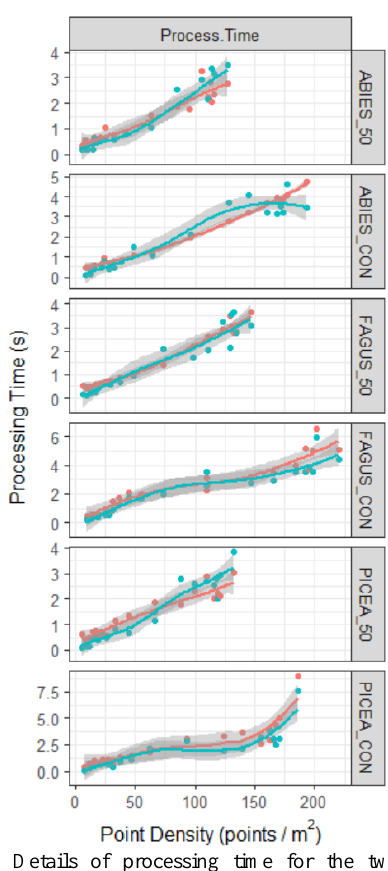
Figure 4. Details of processing time for the two quickest methods, DalPonte (red) and watershed (blue) – legend is same as figure 3.